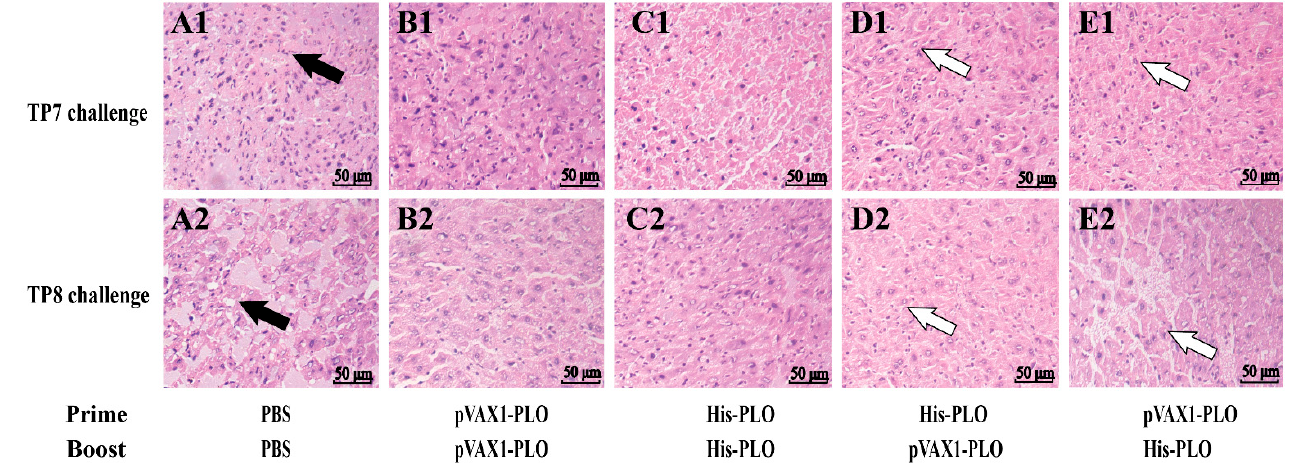
Figure 6. Histological analysis of immunized mice challenged with T. pyogenes . The immunized mice were intraperitoneally challenged at day 43 with T. pyogenes TP7 ( A1 – E1 ) or T. pyogenes TP8 ( A2 – E2 ), respectively. The livers of immunized mice were collected to assess the histology alteration. PBS was used as a control. Abnormal hepatocytes and cellular debris in the PBS group are indicated by the black arrows. The hepatocytes with fewer pathological changes in the prime-boost immunized groups are indicated by the white arrows.